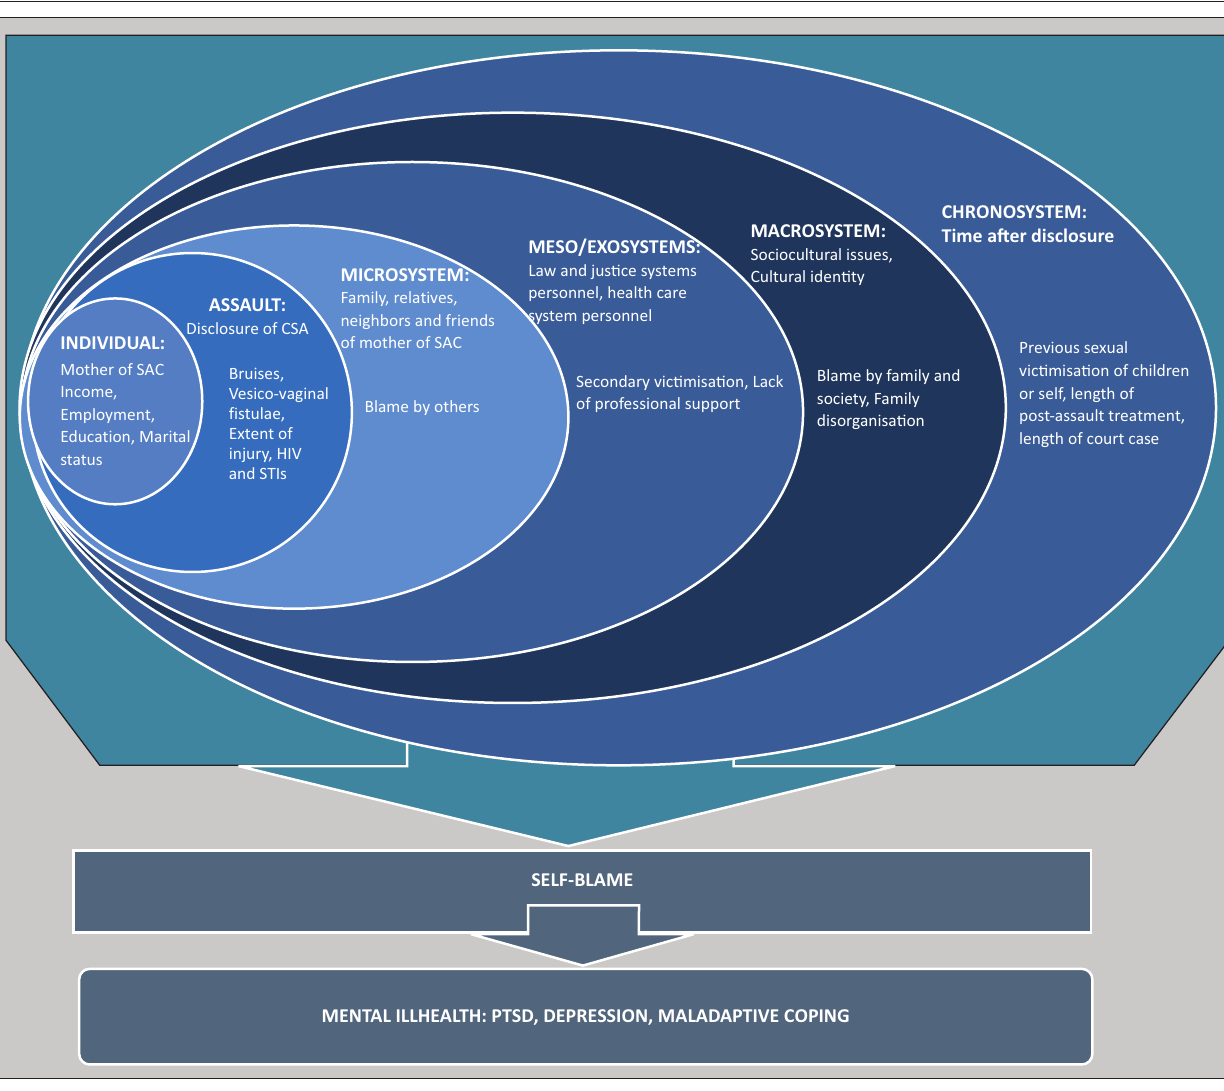
FIGURE 1: Ecological model of the impact of sexual assault on women’s mental